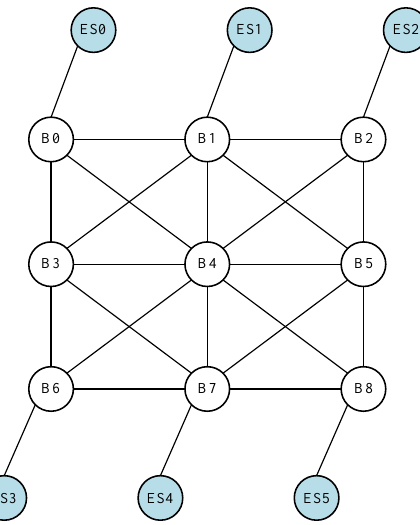
Figure 10. Topology 3, which is a larger topology used in our cases.